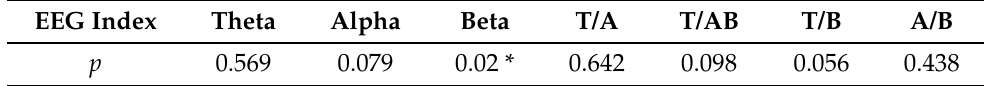
Table 2. Results of the Wilcoxon signed rank test in Experiment 1. EEG Index